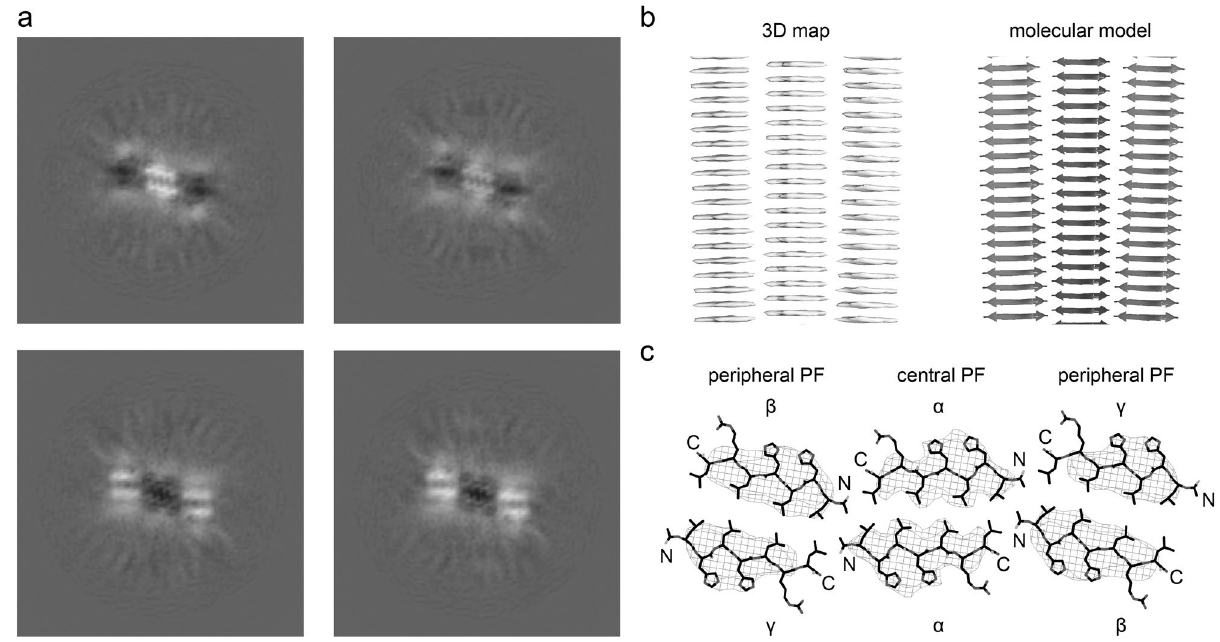
Figure 1. Cryo-EM structure of the catalytic amyloid fibril of peptide acetyl-LHLHLRL-amide. ( a ) 1.04 Å thick slices of the reconstructed 3D map at different z-axial positions. ( b ) Side views of the 3D map (left) and of the molecular model (right, ribbon diagram, PDB entry 8B3A). ( c ) Cross-sectional view of one molecular layer of the reconstructed density (wireframe lattice), superimposed with the molecular model (stick representation). The peptide adopts three topological distinct positions (α, β, γ) in the